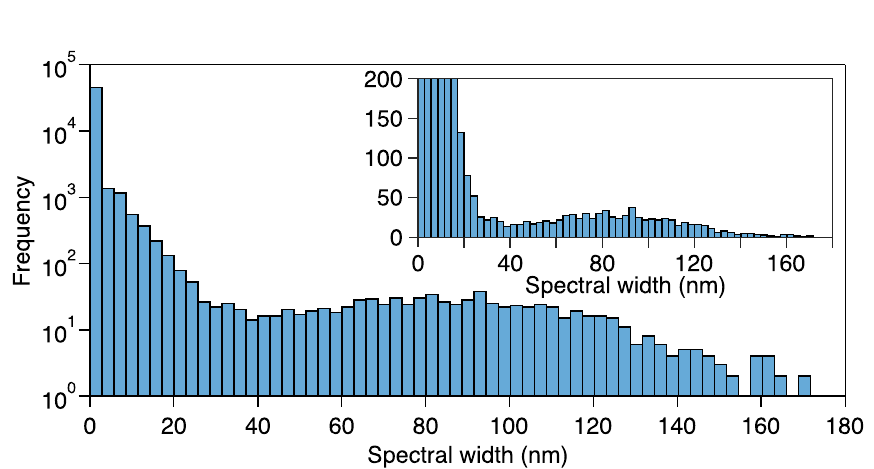
Figure 4. Histogram of the measured − 20 dB bandwidths from the full cavity scan of 50,000 polarization settings of the saturable absorber. The main plot uses a logarithmic scale for the vertical axis whereas the inset shows an exploded view on a linear scale to illustrate the long-tailed nature of the